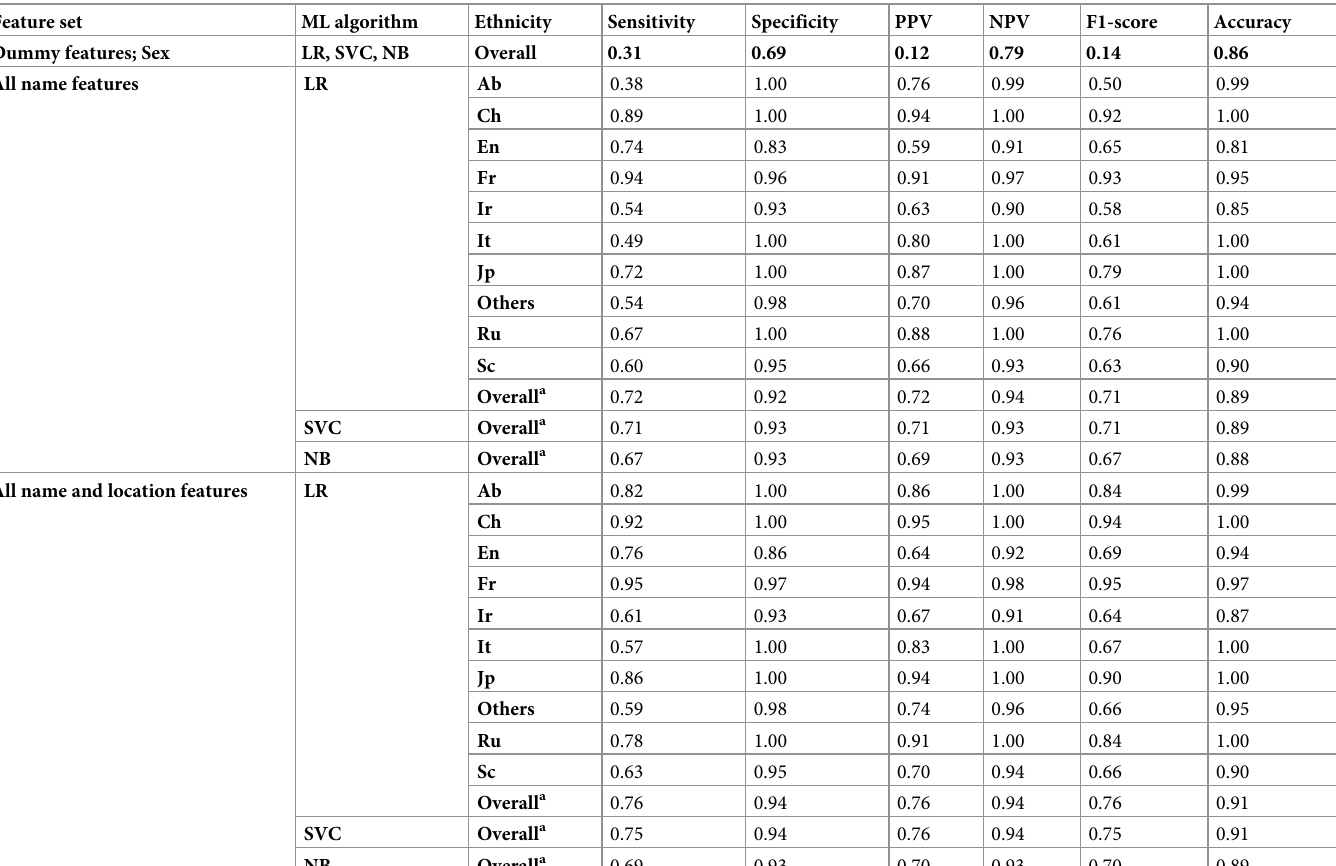
Table 3. Multiclass classification predictive performance in test set with ML models trained in training set. Feature set